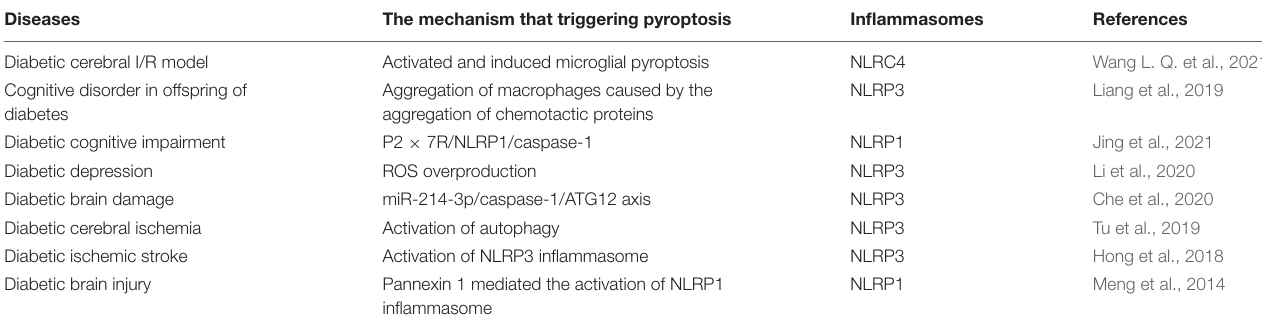
TABLE 1 | Researches on the pyroptosis in diabetic